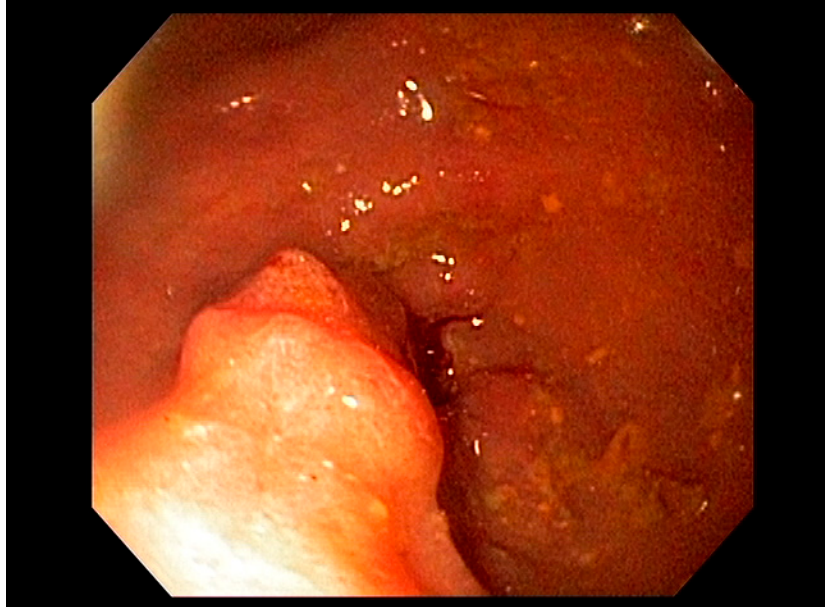
Figure 9. High-definition white light endoscopy (HD-WLE) combined with optical chromoendoscopy techniques such as narrow-band imaging (NBI) and targeted biopsies.